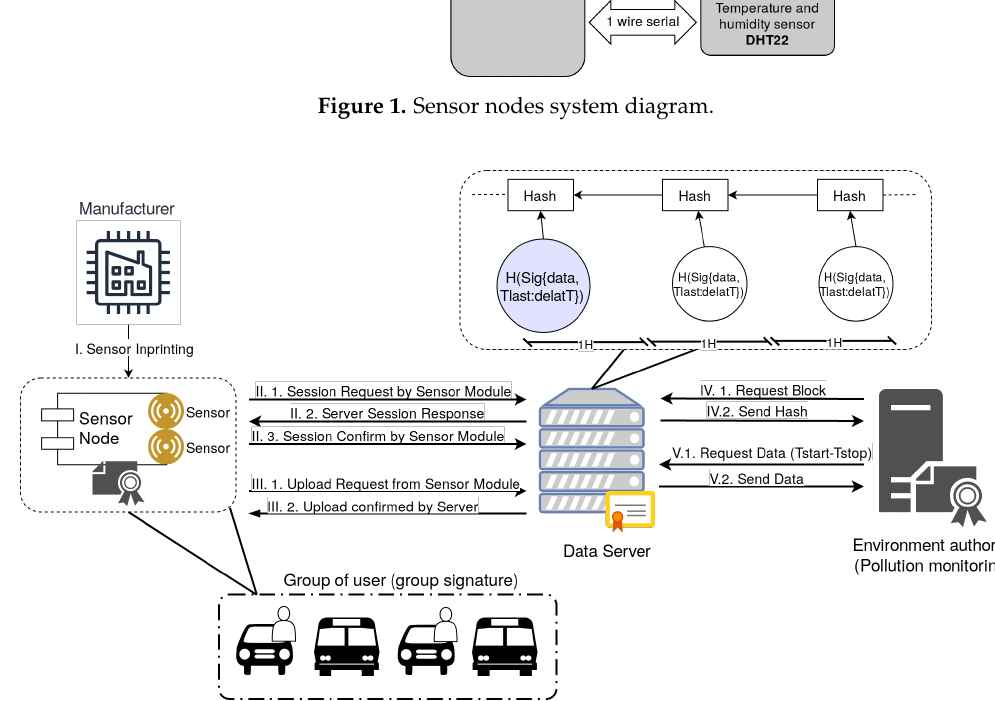
Figure 2. Overview of the proposed